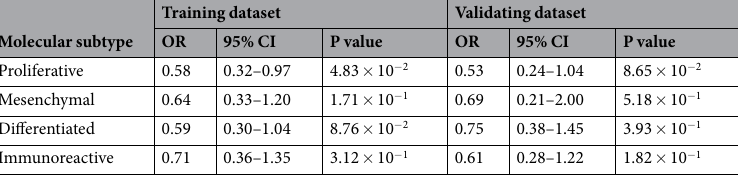
Table 3. Relationship between ZFAS1 with chemosensitivity in ovarian cancer molecular